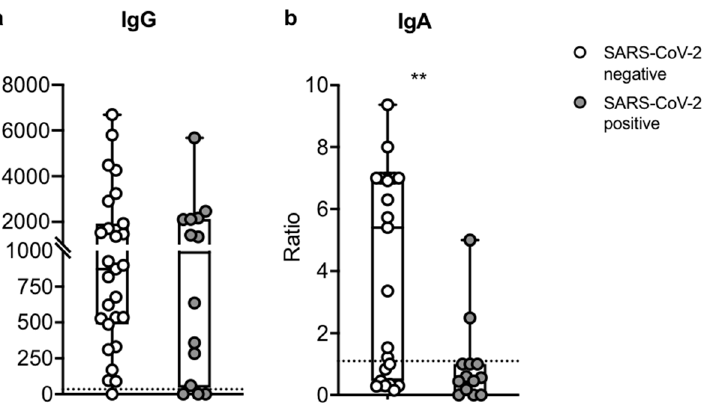
Figure 3. Humoral assessment in uninfected– (n = 27) and infected–vaccinated SOTRs (n = 14) after the third dose of mRNA vaccine. ( a ) Comparison of IgG Spike (BAU/mL) in uninfected– (white dots) and infected–vaccinated SOTRs (grey dots) after the third booster dose. ( b ) Comparison of IgA Spike Ratio in uninfected– (white dots) and infected–vaccinated SOTRs (grey dots) after the third booster dose. The dotted line corresponds to the threshold. The significance was determined using the Mann–Whitney U test, ** p = 0.0054.